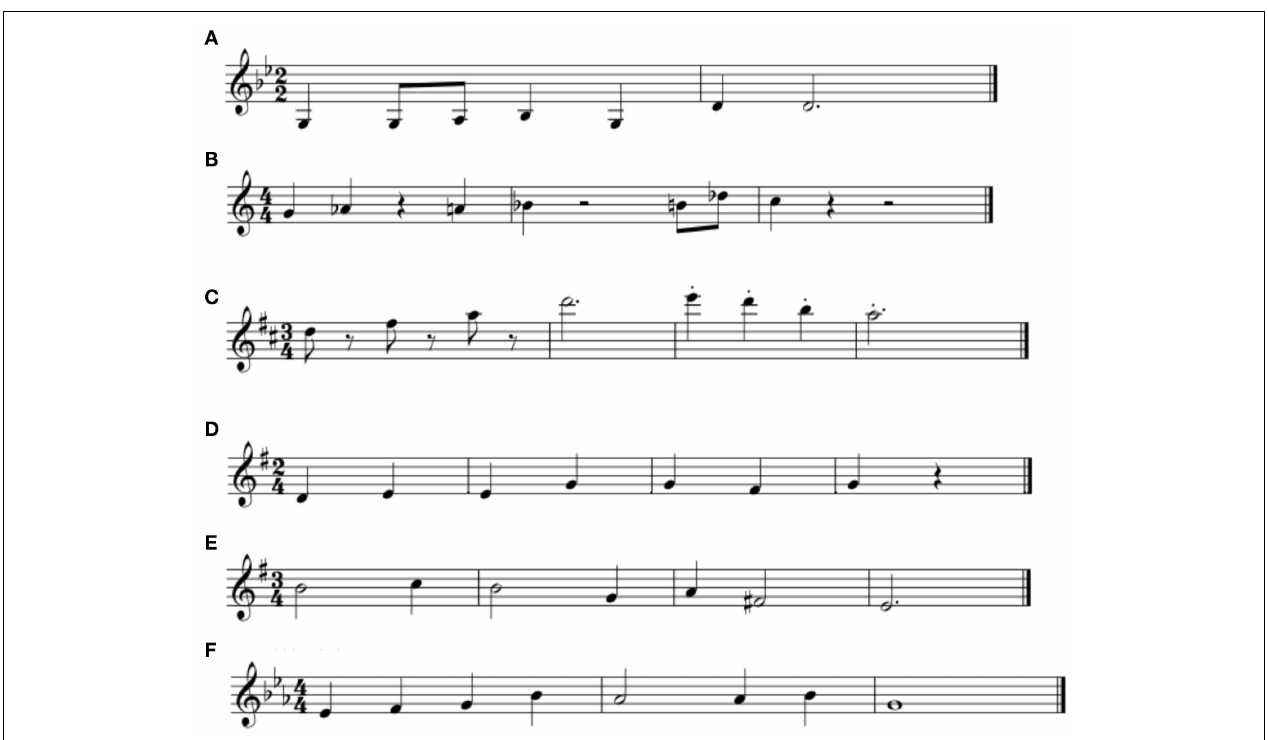
FIGURE 1 | Notated exemplars of the melodies expressing anger (A), fear (B), happiness (C), neutral (D), sadness (E), and tenderness (F) .